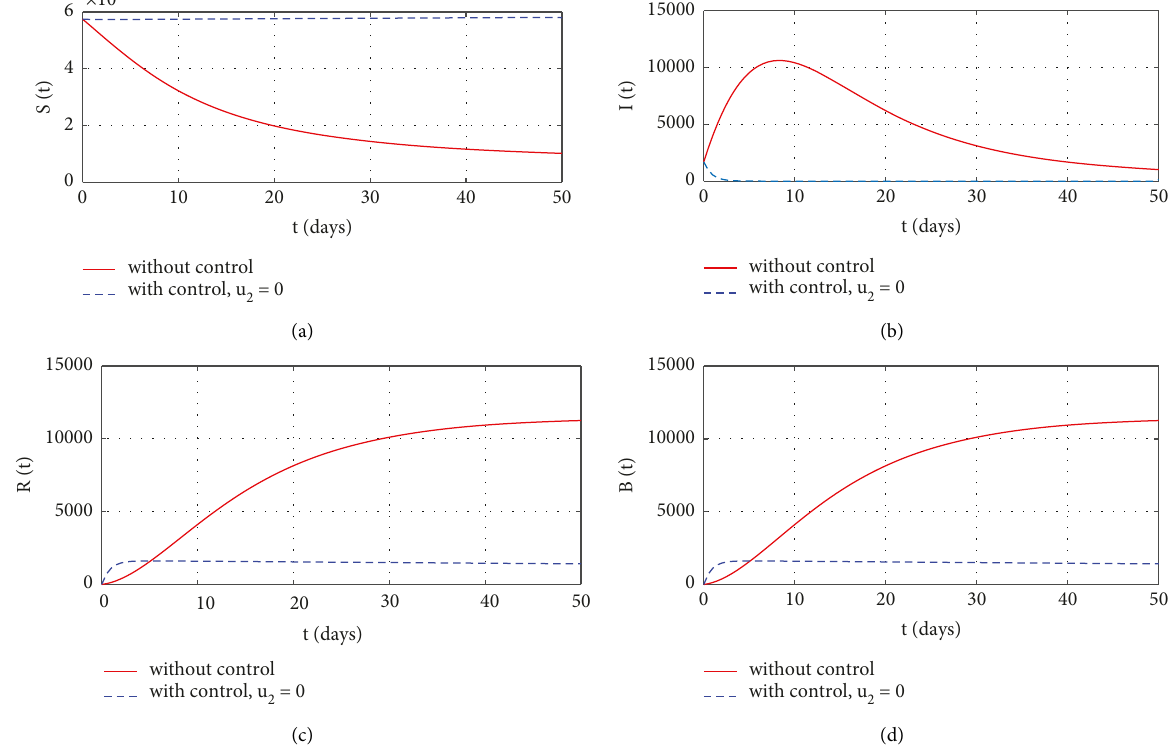
Figure 6: Simulations of the cholera model showing the effect of optimal control strategy with hygiene, treatment of infective individuals, and chlorination control measures.